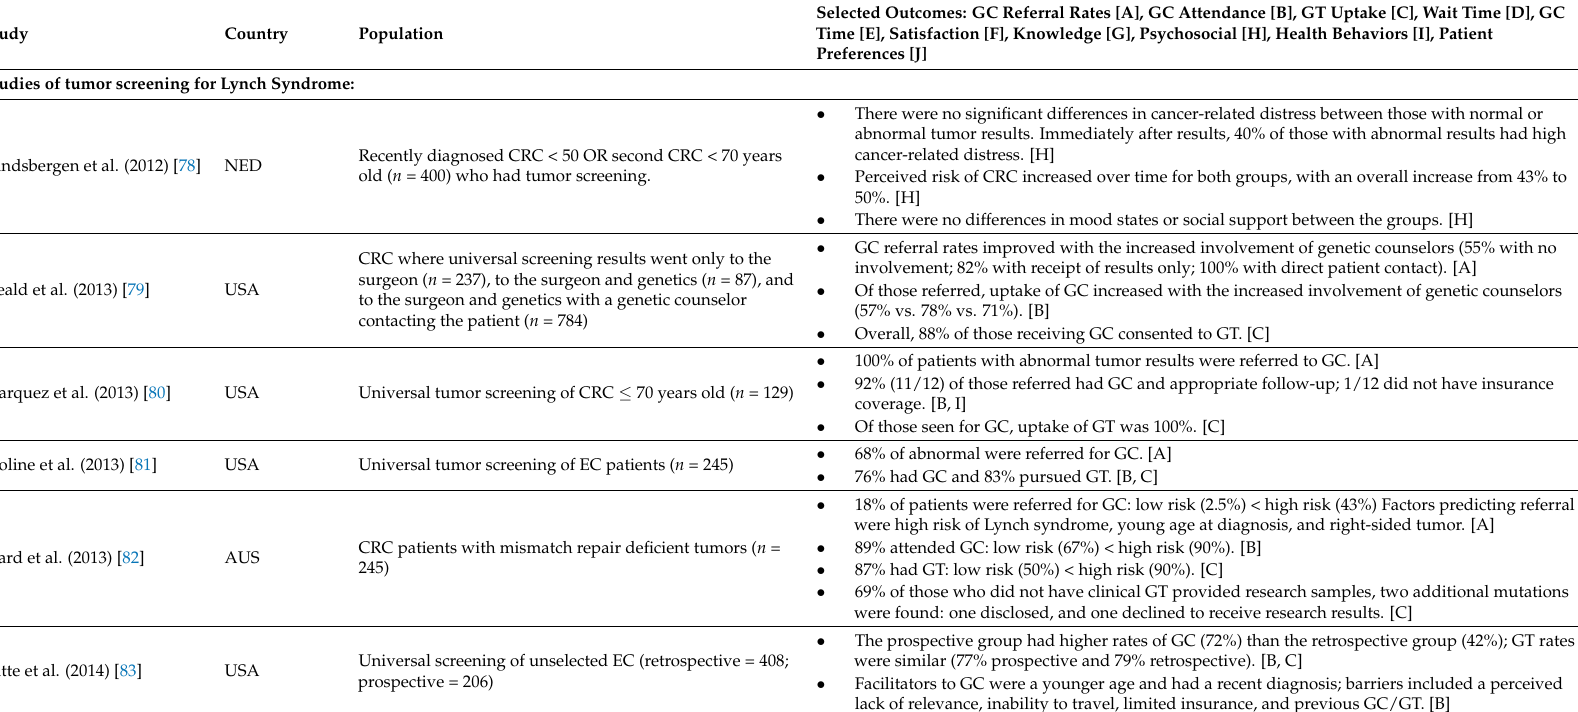
Table 7. Tumor-first genetic testing